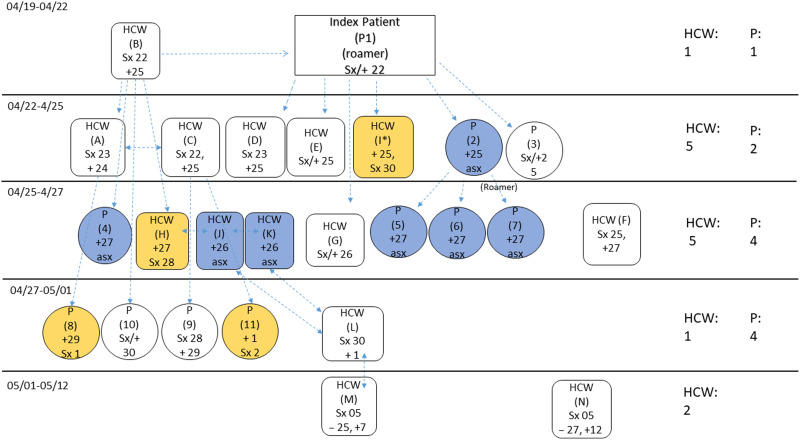
Transmission tree. Note. HCW, healthcare worker; Sx, symptomatic; asx, asymptomatic; —, presymptomatic transmission; (number), patient identifier; (letter), healthcare worker identifier; +, positive test; number, day of the month; yellow box/circle, presymptomatic; blue box/circle, asymptomatic.